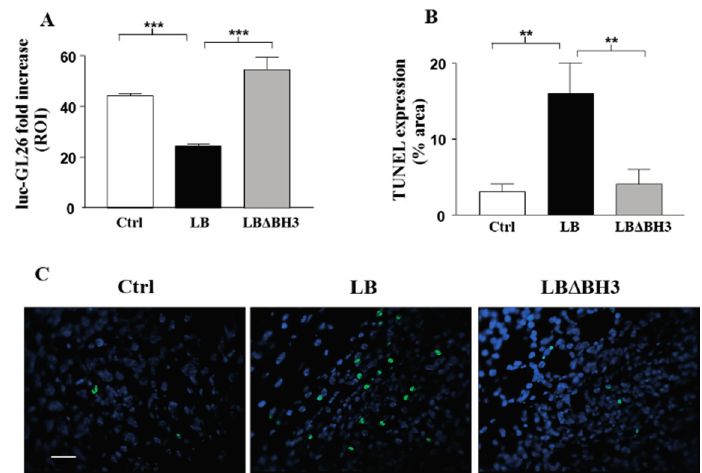
Figure 5. Bak Liposomes (LB) anti-tumor effects correlate with increased TUNEL staining in glioblastoma cells. ( A ) Tumor expansion over time in response to intravenous LB and LB Δ BH 3 administration evaluated by bioluminescence imaging (BLI) in luc-GL26-bearing mice ( n = 5/group). Columns represent, in region of interest (ROI), the ratio between the tumor size at the first day of the treatment and the size of the tumor one week after the last treatment. *** p < 0.001, LB vs. Ctrl and vs. LB Δ BH 3 ; ( B ) Evaluation of TUNEL staining on tumors removed from mice ( n = 3/group). ** p < 0.01, LB vs. Ctrl and vs. LB Δ BH 3 ; ( C ) Representative fluorescent images of TUNEL staining. Bar: 50